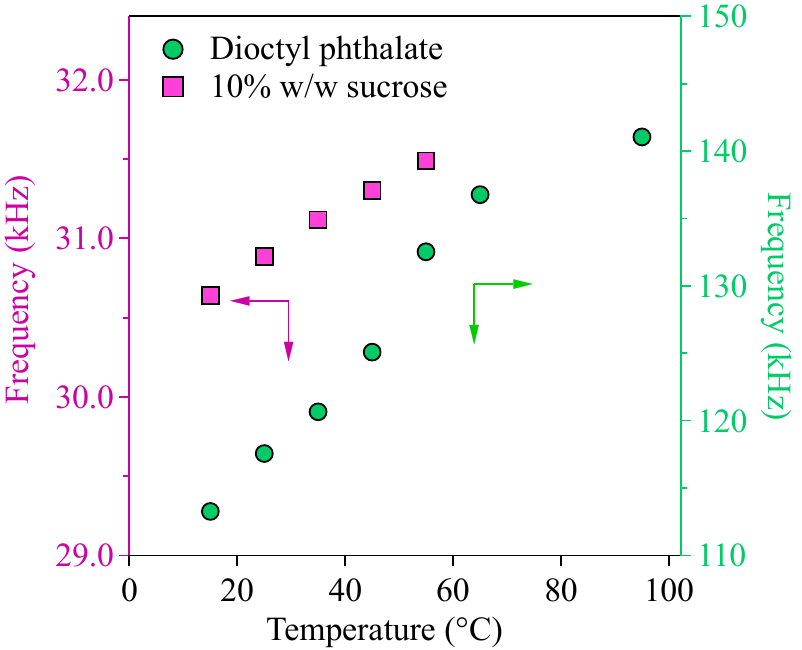
Figure 3. Resonance frequencies of AMF cantilever in the 10% w / w sucrose and dioctyl phthalate at temperatures from 15 ◦ C to 90 ◦ C. (Cantilever AC240TSA-R3 was used for 10% w / w sucrose; cantilever AC160TS-R3 was used for the dioctyl phthalate). The closed symbols are the average resonance frequencies of three measurements. The shaded areas are the standard deviation of the three measurements.